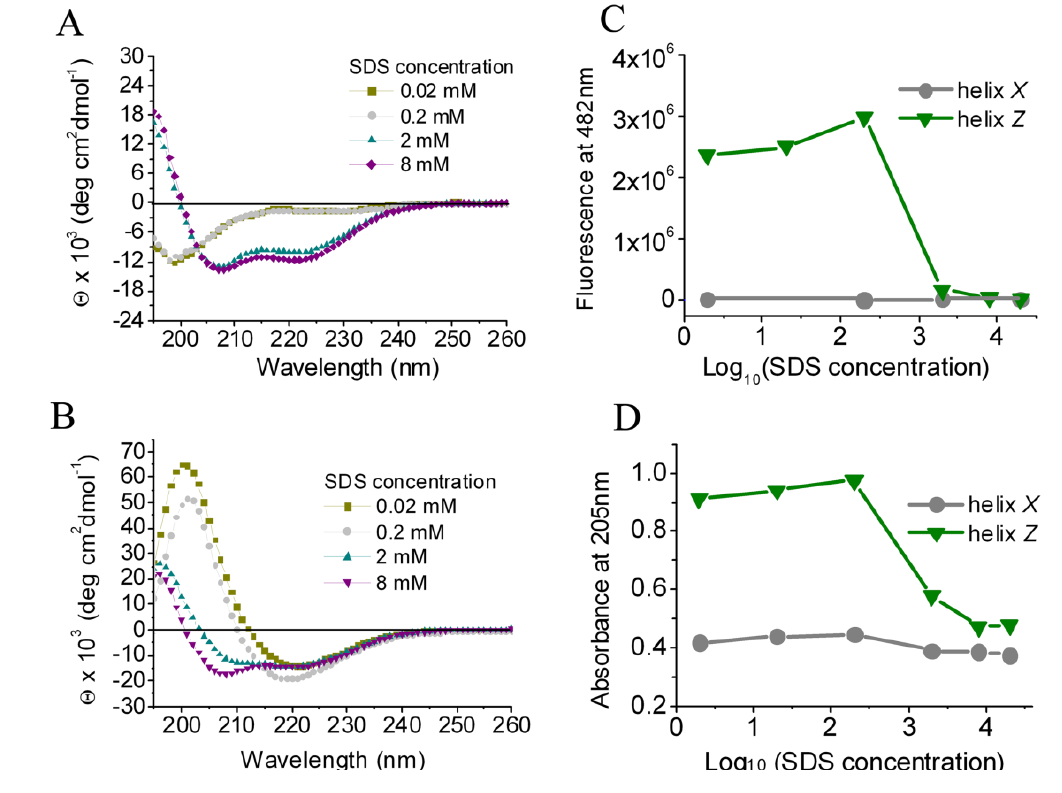
Figure 4. The effect of SDS on the secondary structure of peptides monitored by CD. ( A ) helix- X ; ( B ) Helix- Z ; ( C ) ThT fluorescence at 482 nm; ( D ) Absorbance at 205 nm. The peptide concentration used in all CD assays was 200 µg/mL. For ThT assays was 50 µg/mL and for absorbance assays 180